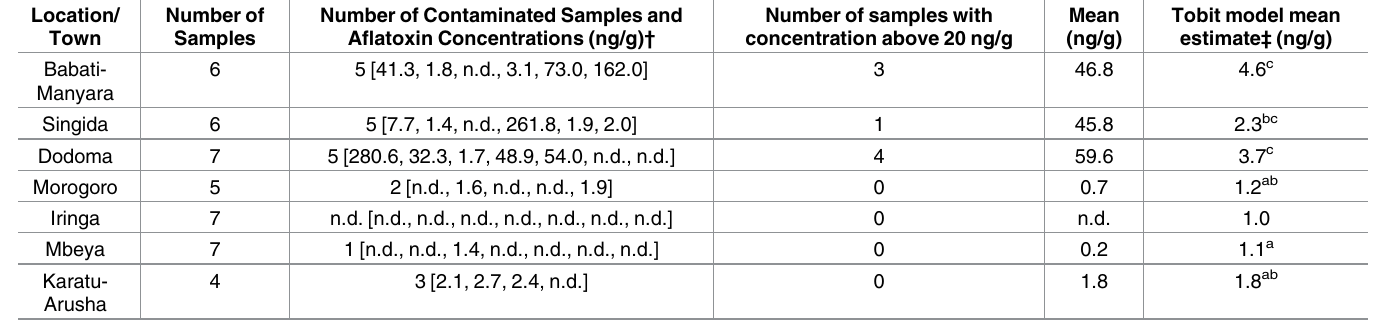
Table 2. Aflatoxin concentrations in sunflower seeds collected from micro- and small-scale sunflower oil processors in Tanzania in the sun- flower-harvesting season of